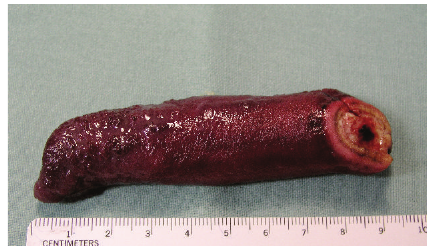
Figure 8: The fibrolipoma after endoscopic polypectomy.